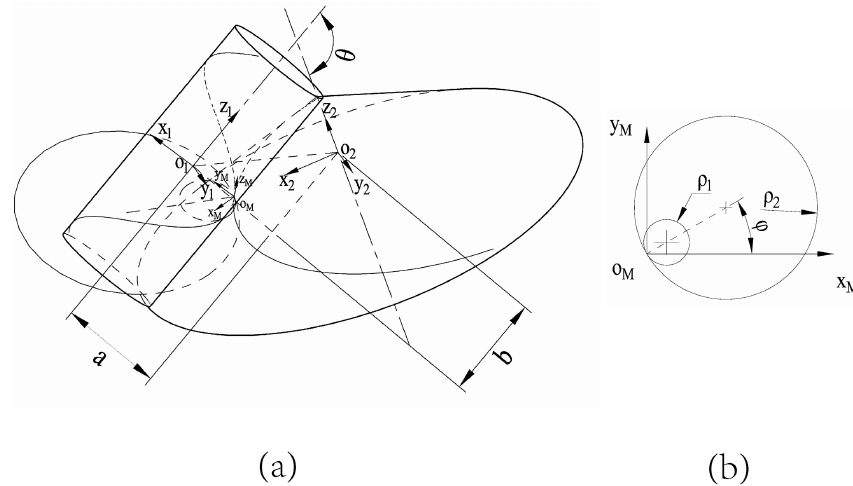
Figure 1. A pair of concave convex arc line gears at the meshing